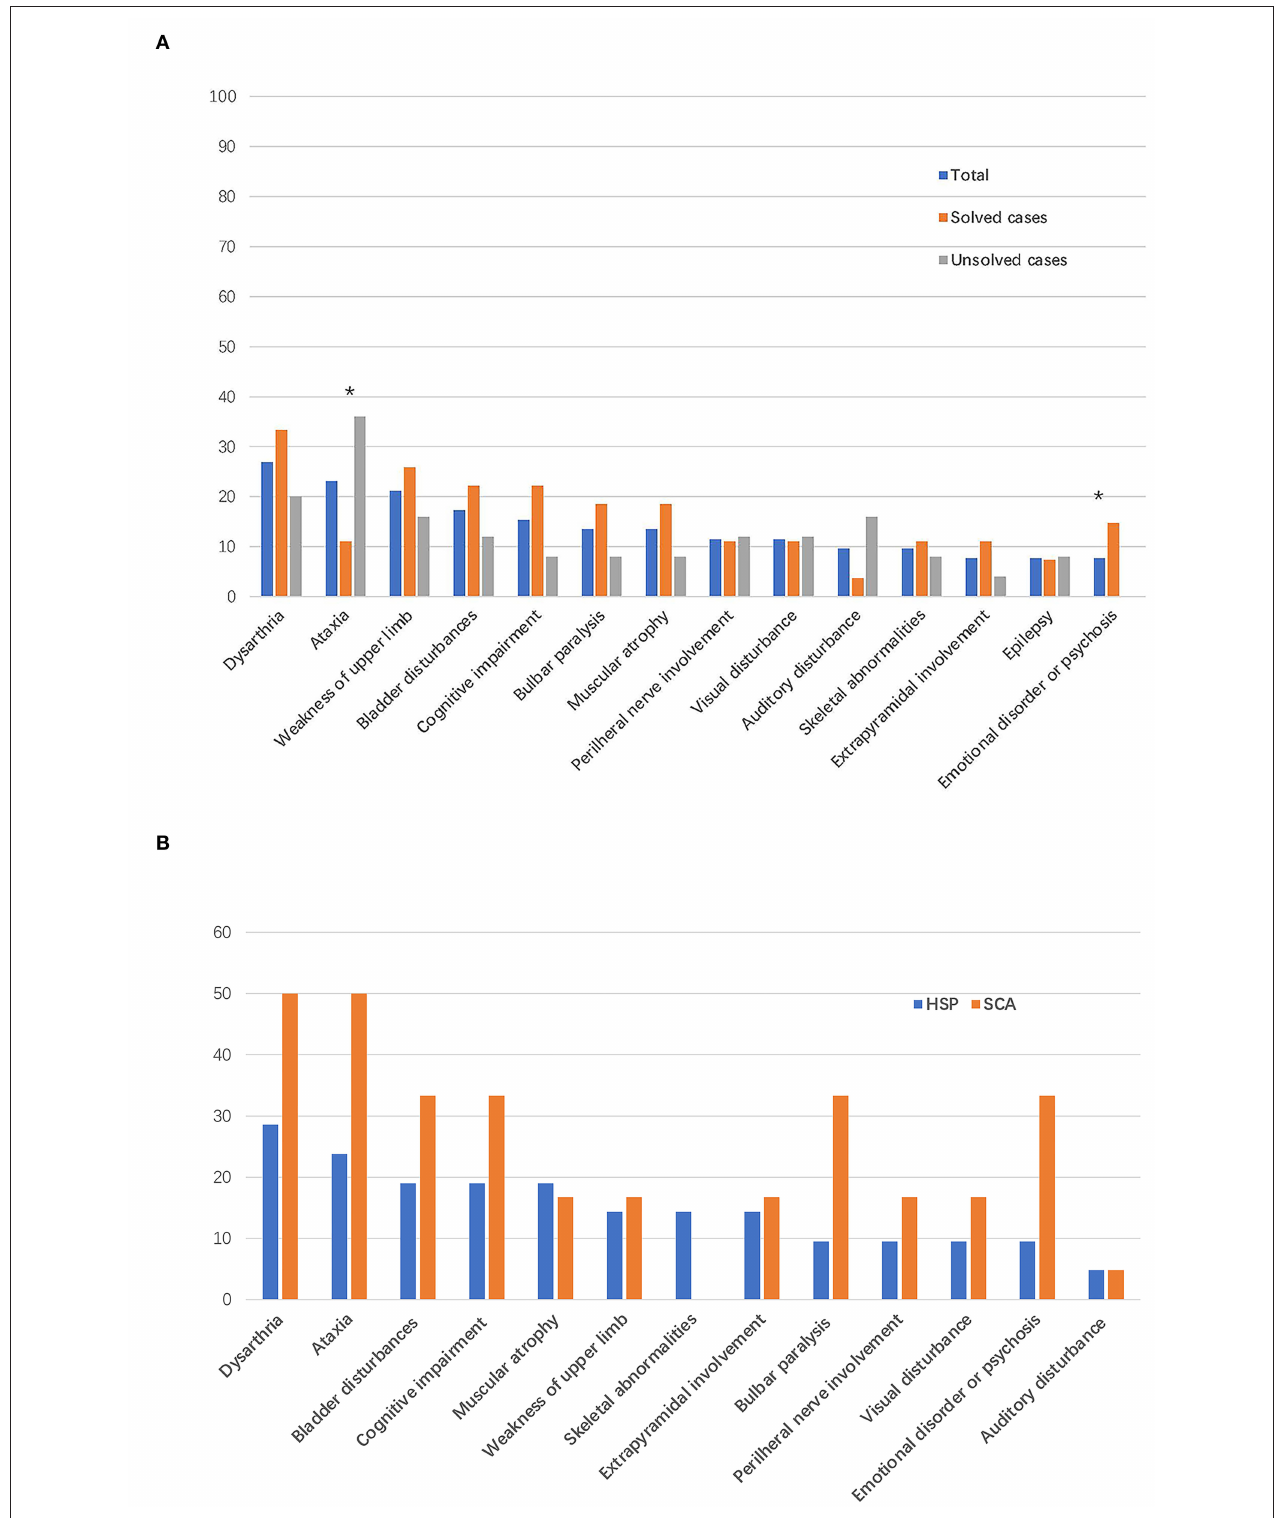
FIGURE 3 | Frequency of complicating signs and symptoms. The bar indicates the proportion of patients with a given sign or symptom. (A) Frequency of complicating signs and symptoms in all the patients enrolled in this study and in patients with vs. without defined genetic causes. * P < 0.05. (B) Frequency of complicating signs and symptoms in patients with final diagnoses of HSPs and spinocerebellar ataxias (SCAs).